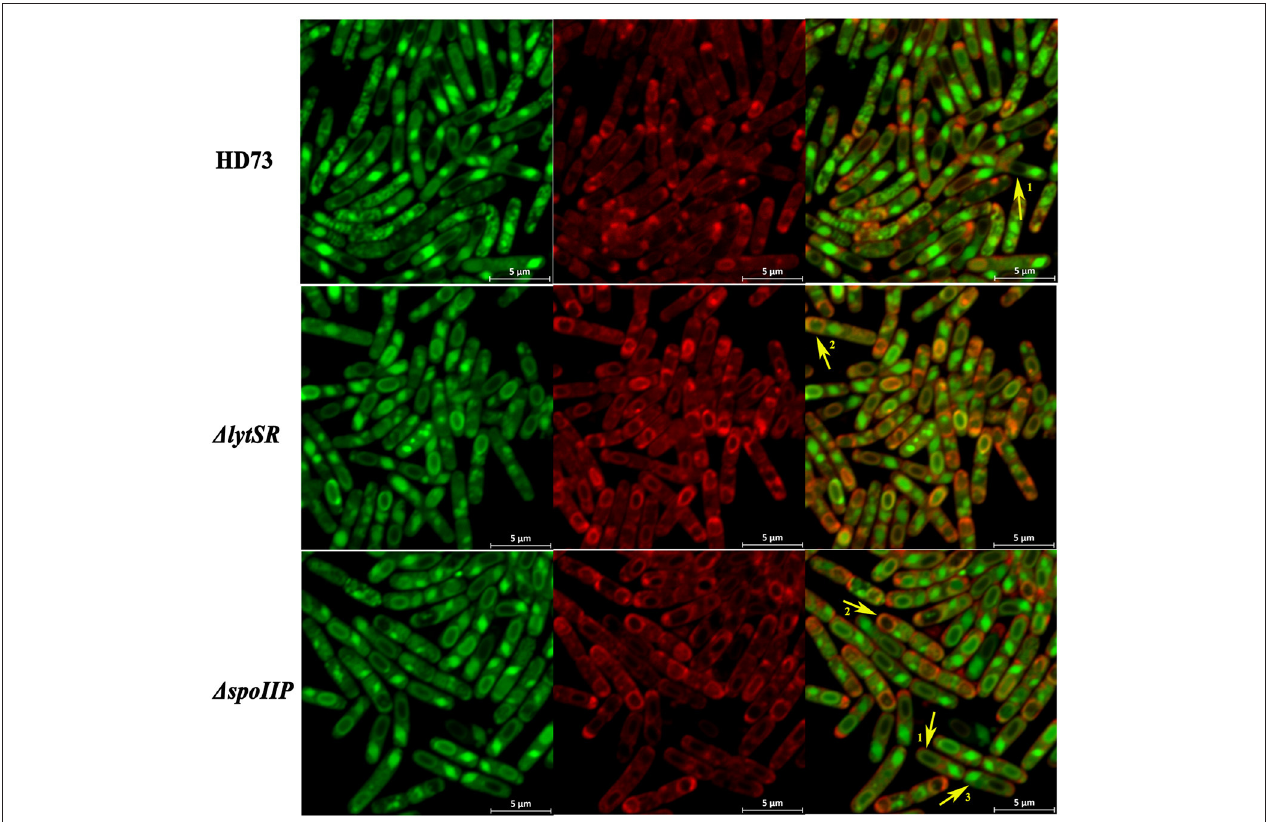
FIGURE 5 | Schematic representation of the membrane fusion assay. Laser scanning confocal micrographs of Bt wild-type HD73, 1 lytSR , and 1 spoIIP cells grown in SSM to T 12 (30 ◦ C). Red lines represent membranes stained with FM4-64 and MitoTracker Green FM (MTG), and green lines indicate membranes stained with MTG only. Arrow 1 points to cells that have completed the process of engulfment; only the mother–cell membranes are stained with FM4-64, but MTG stained both the forespore and mother–cell membranes. Arrow 2 points to cells that have undergone incomplete engulfment, and the membrane fusion is stained with FM4-64 and MTG. Arrow 3 points to the crystal protein stained with MTG